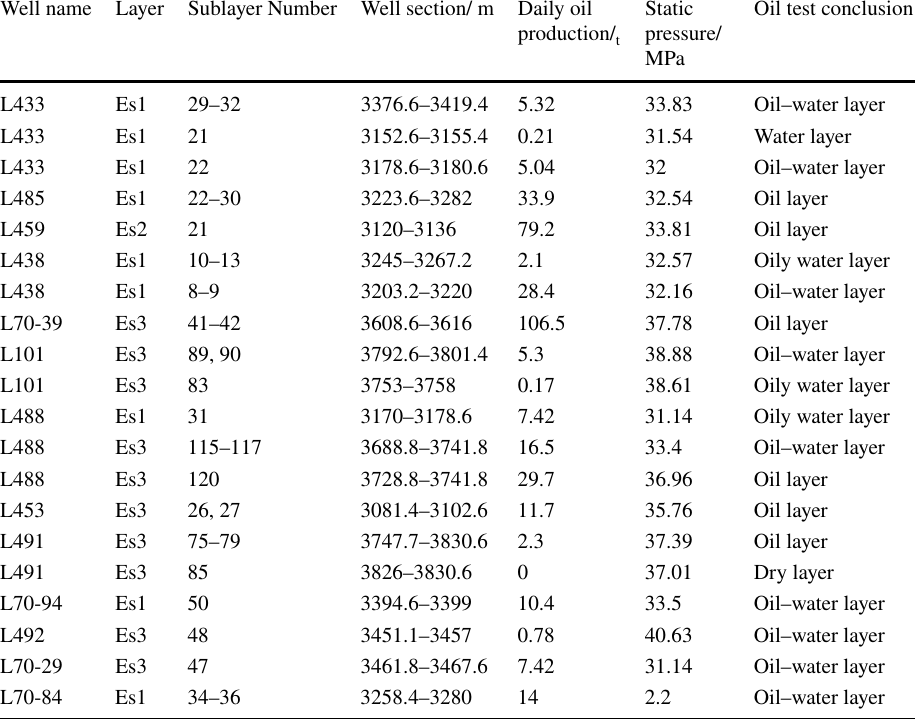
Table 1 Oil test data in the study